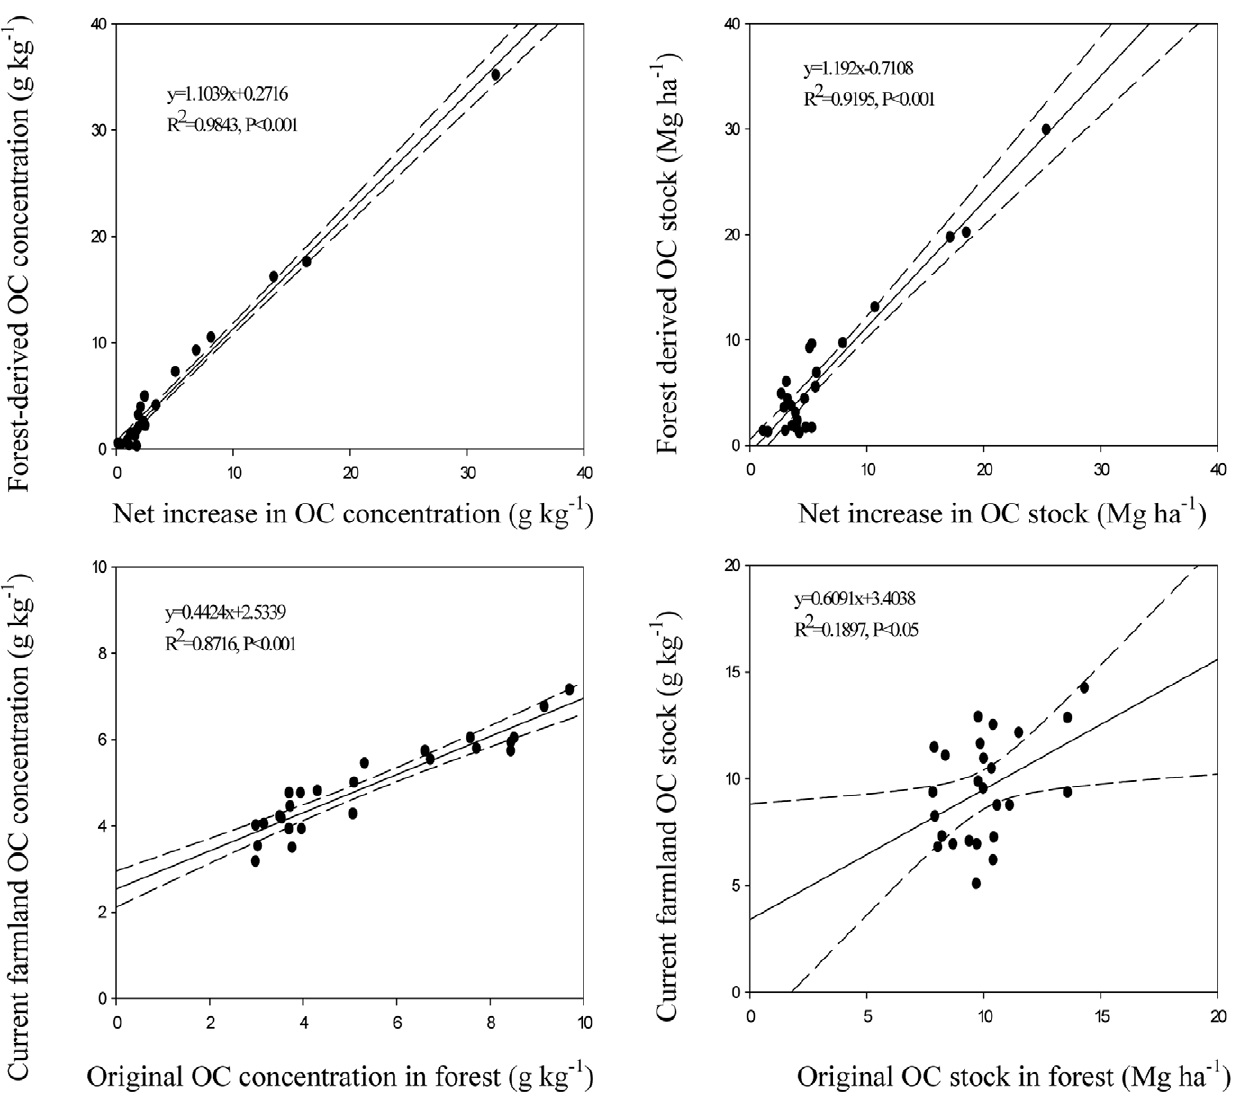
Figure 6. Relationships between forest-derived OC (C 3 -C) and the net increase in OC in afforested soil, and between original OC in afforested soil (C 4 -C) and the OC in current farmland (the inner bound represents the 95% confidence interval).